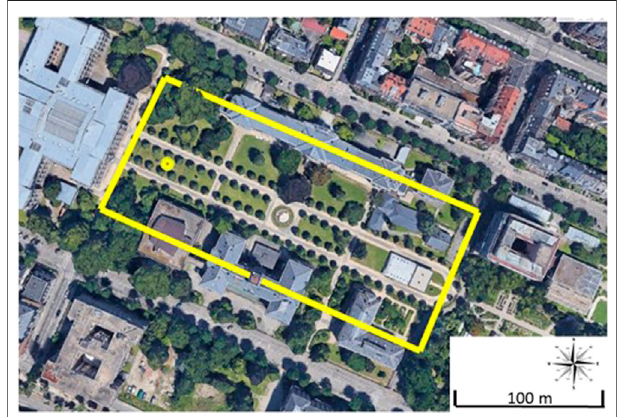
FIGURE 3 | Aerial view of experimental site. The location of the measurement mast isshown with the yellow point. The area correspondingto the yellow rectangle is considered as an urban